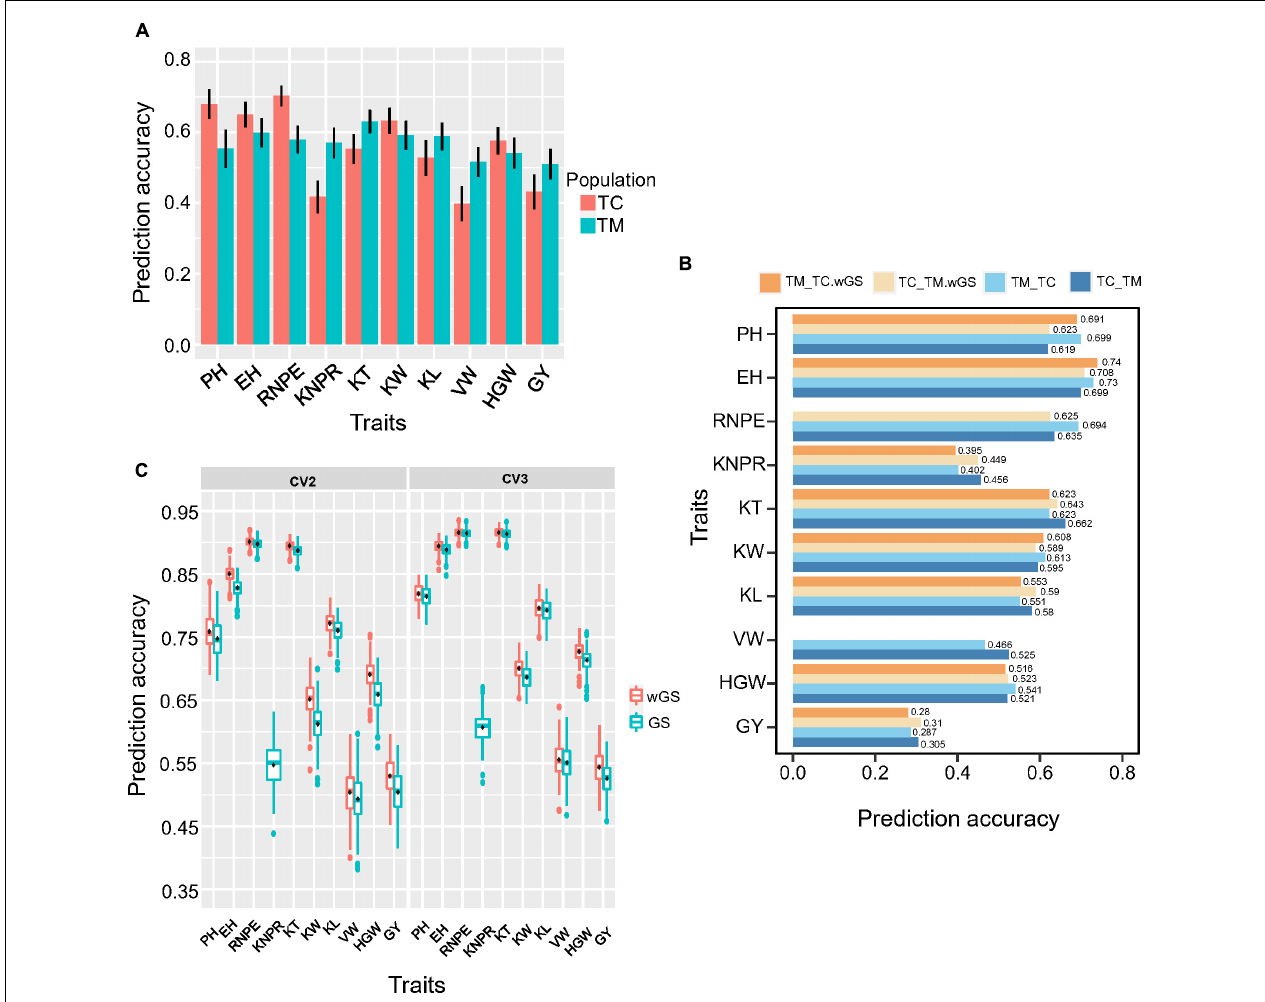
FIGURE 7 | Genomic prediction accuracy of different cross-validation strategies. (A) Prediction accuracy within Chang7-2 × RIL (TC) and Mo17 × RIL (TM) population. RIL, the recombinant inbred line population developed by Ye478 × Qi319. (B) Prediction accuracy of 10 traits of cross-validation strategy 1 (CV1). TC_TM represents TM predicted by the TC population; TM_TC represents TC predicted by the TM population. (C) Prediction accuracy of 10 traits of cross-validation strategy 2 (CV2) and cross-validation strategy 3 (CV3). wGS is a weighted genomic selection that incorporates the peak single nucleotide polymorphisms (SNP) of potential target quantitative trait loci as fixed effects. PH, plant height; EH, ear height; RNPE, row number per ear; KNPR, kernel number per row; KT, kernel thickness; KW, kernel width; KL, kernel length; VW, volume weight; HGW, hundred grain weight; GY, grain yield per